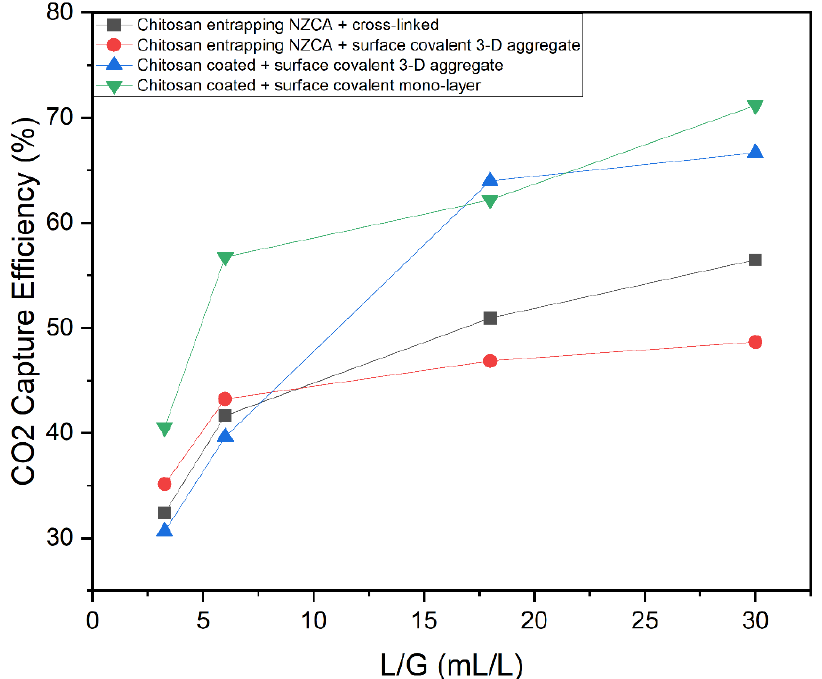
Figure 6. CO 2 capture efficiencies of biocatalytic textile packings immobilized with NZCA using various methods involving crosslinking agent tested with varying 10 wt% K 2 CO 3 solvent flow rates from 13 mL/min to 120 mL/min and a fixed total gas flow rate of 4 L/min (3.6 LPM N 2 and 0.4 LPM CO 2 ).